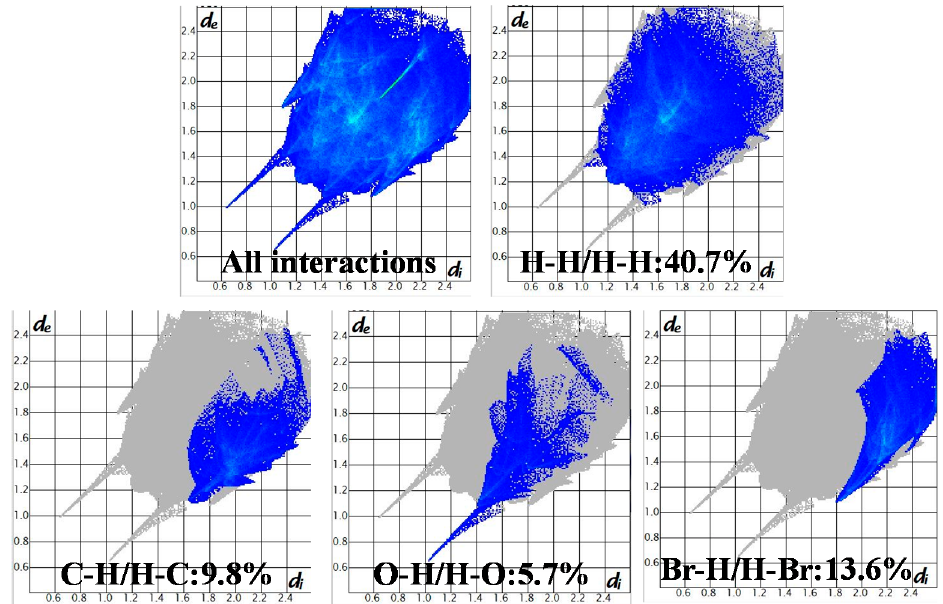
Figure 8. Finger-print plot of percentages of contacts on the Hirshfeld surface in the Co(II) complex.